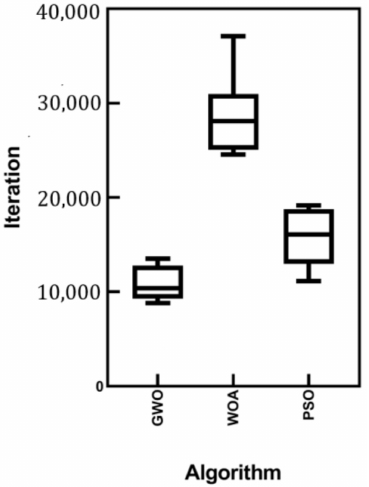
Figure 11. Boxplots of the iterations for GWO, WOA and